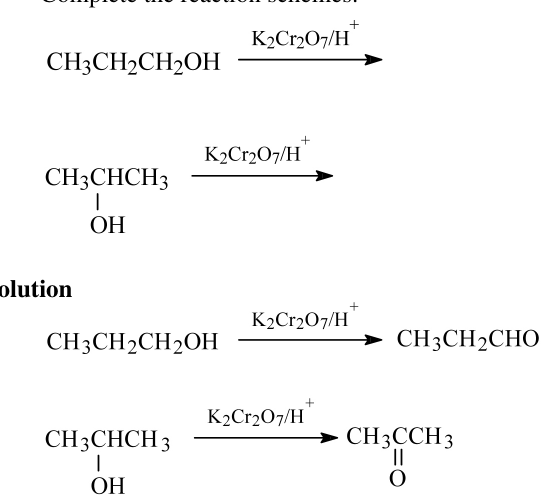
Table 7. Oxidation of the propan-1-ol, percentages of correct and incorrect answers.